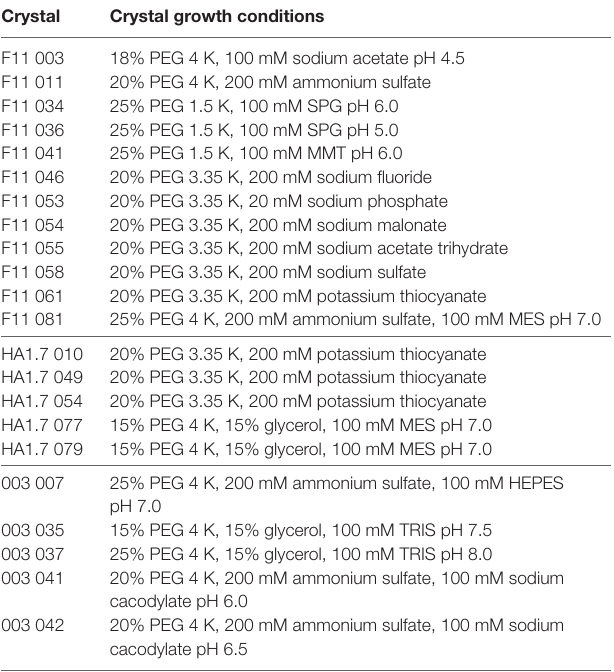
Table 1 | Crystallization conditions for TCR structures. crystal crystal growth